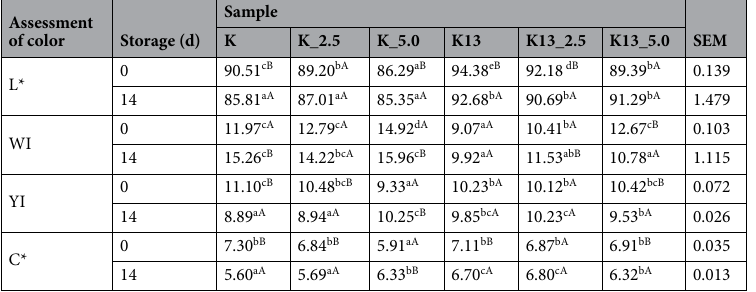
Table 4. Change assessment of the color of kefir with honeydew honey during storage. K, model kefir; K13, commercial kefir; K_2.5, model kefir with 2.5% honeydew honey; K_5.0, model kefir with 5.0% honeydew honey; K13_2.5, commercial kefir with 2.5% honeydew honey; K13_5.0, commercial kefir with 5.0% honeydew honey; d, day; L*, brightness; WI, white index; C*, chrome; YI, yellowing index; SEM, standard error of the mean (n = 8). a–e, A–B Different lowercase letters in the superscript in rows and capital letters in columns for each parameter indicate statistically significant differences at the level α =